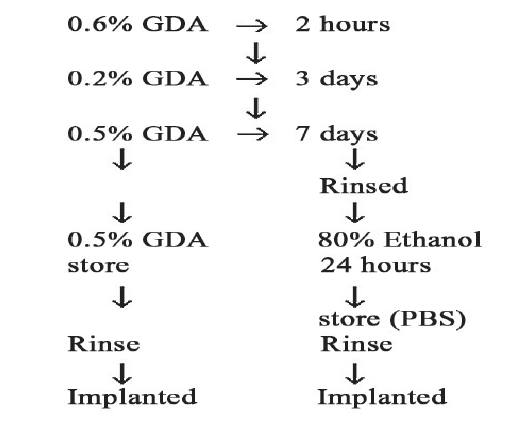
Fig. 3 - Heteroenxerto valvar pulmonar porcino, tratado com etanol, após retirada, onde se observam suas cúspides sem calcificação e delgadas